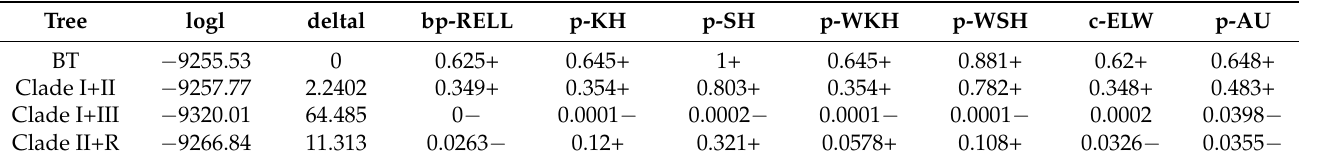
Table 1. Results of topology test. Scores of constrained trees: (BT) = Best unconstrained tree, (Clade I + II) = M. uva-maris , M. reginae , M. recarensis and M. antarctica . (Clade I + III) = M. recarensis , M. antarctica and freshwater Microglena species and (Clade II + R) = M. redcarensis , M. uva-maris and M.